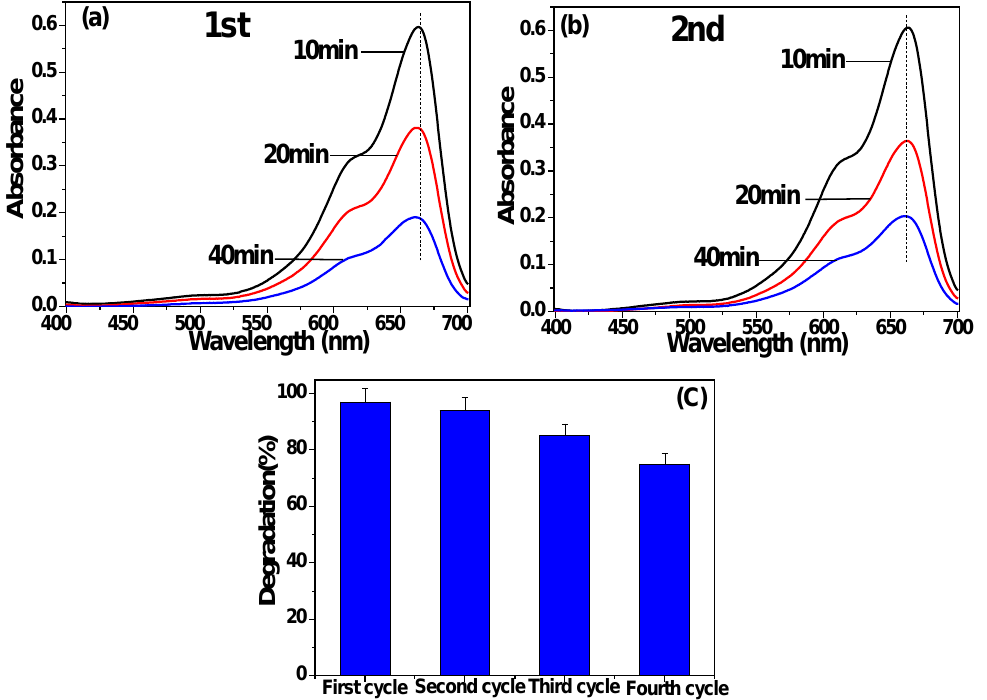
Figure 12. Absorption spectra of MB solution at different periods of the time in the presence of C-S1 under visible light in ( a ) the first cycle and ( b ) the second cycle; ( c ) photocatalytic degradation of MB after up to four cycles measured after visible light irradiation of duration 240